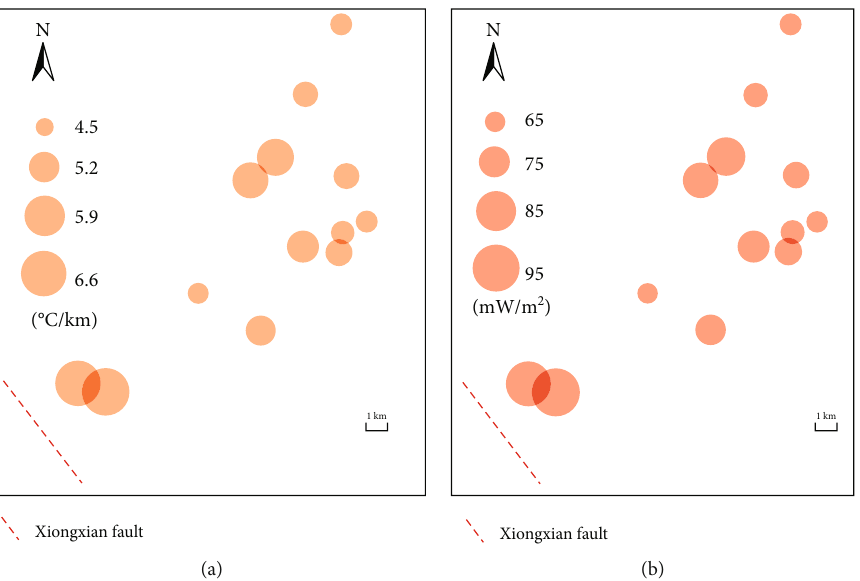
Figure 4: The bubble map of (a) temperature gradient and (b) heat fl ow based on the borehole data at Xiongxian geothermal